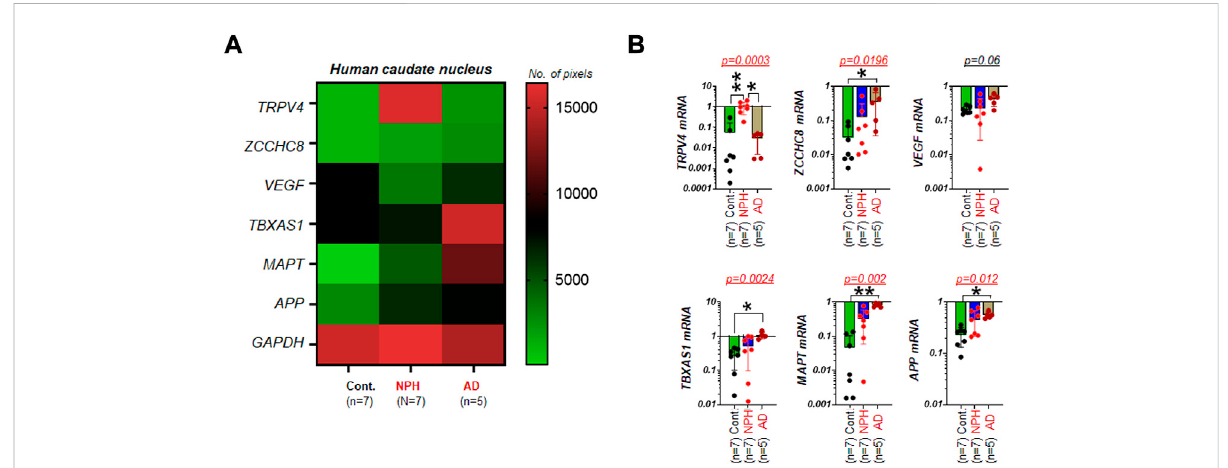
FIGURE 2 TRPV4 mRNA inthe caudate nucleus is elevated in NPH but not inAD (A) A color-codedmap illustrating thesummaryof themRNA assay result on expression levels of TRPV4 and fi ve other genes associated with either NPH or AD in the caudate nucleus of humans with unaffected control (Cont.), NPH, and AD, respectively. The number of pixels from ImageJ with coded color was shown on the right. Note that TRPV4 and VEGF mRNA were not altered in AD as compared controls. N = 5-7 per group. (B) bar graphs with scatter plots summarizing mRNA expressions of multiple genes relative to GAPDH in AD (n = 5) as compared to those of Cont. (n = 7). **, p < 0.01; *, p < 0.05 by Kruskal-Wallis